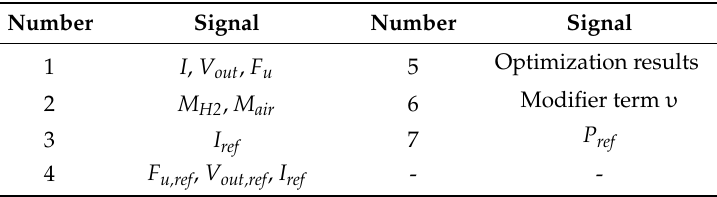
Figure 5. The control scheme designed for optimal SOFC operation. Table 2. The components of signal flow in designed control